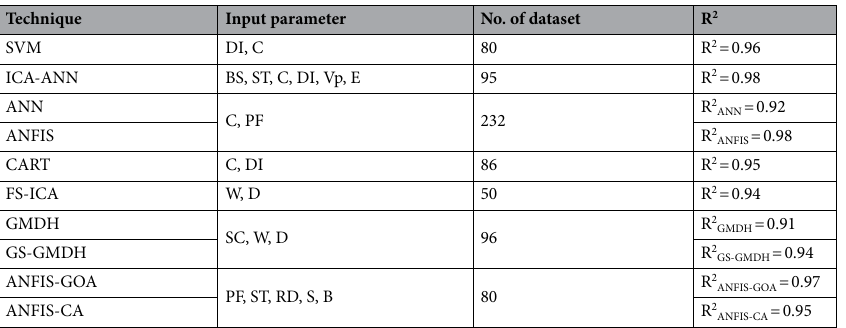
Table 1. Some studies of PPV prediction using soft computing methods 33–39 . SVM support vector machine, ICA imperialist competitive algorithm, ANN artificial neural network, ANFIS adaptive neuro-fuzzy inference system, CART classification and regression tree, FS fuzzy system, GMDH Group Method of Data Handling, GS generalized structure, GOA grasshopper optimization algorithm, CA cultural algorithm, DI distance from the blasting face, C charge per delay, BS burden to spacing, ST stemming, Vp P-wave velocity, E Young